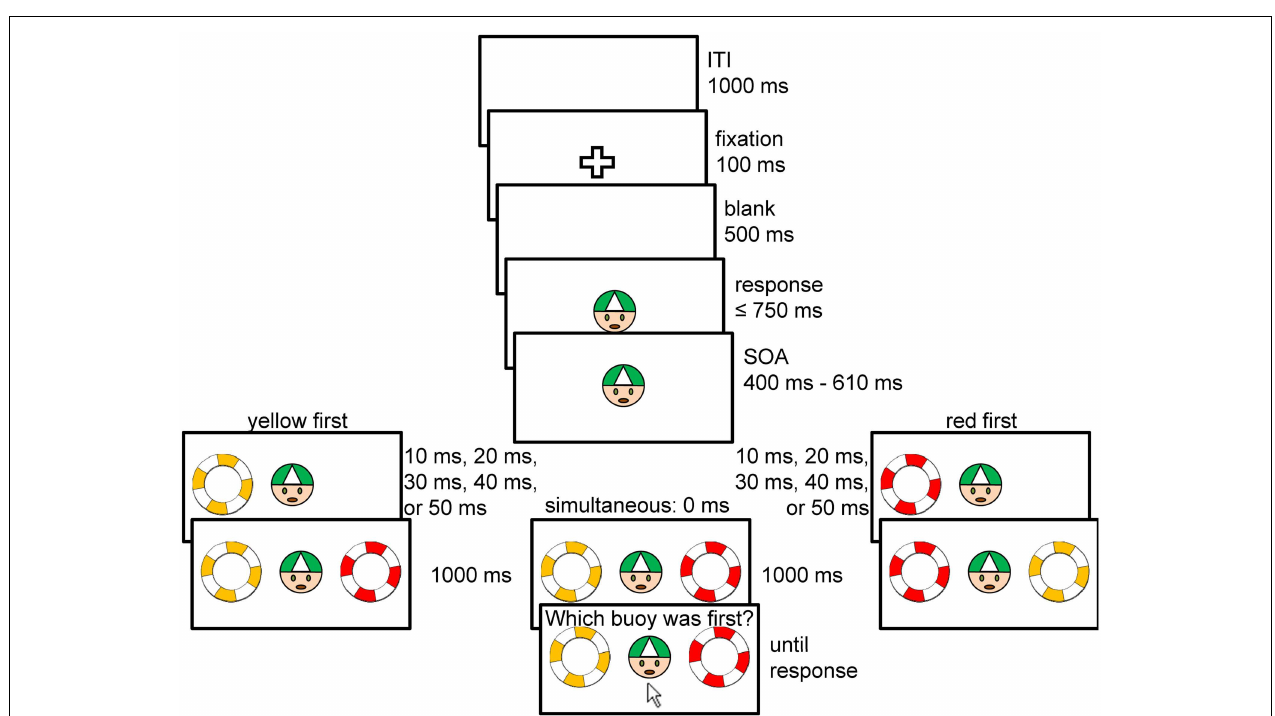
and yellow stimuli on the screen was counterbalanced within participants. For better readability in the figure the background color is shown in white instead of blue in the experiment and texts are printed in black instead of